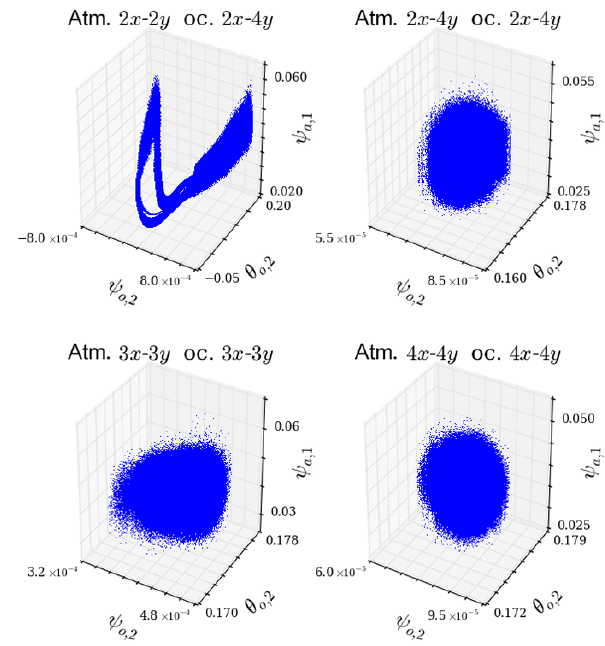
Figure 1. Cross section of the attractors for various model resolu- tions. The atmospheric and oceanic resolutions are both indicated above each panel. The parameters are given in Table 1.